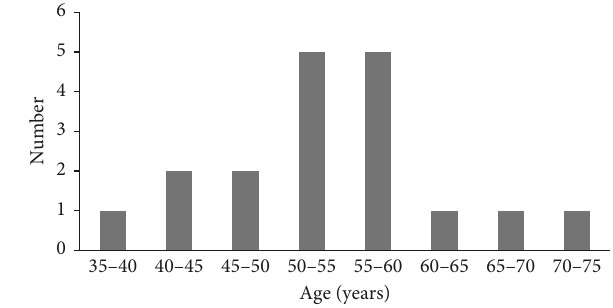
Figure 1: Age distribution of patients with CCAC ( n